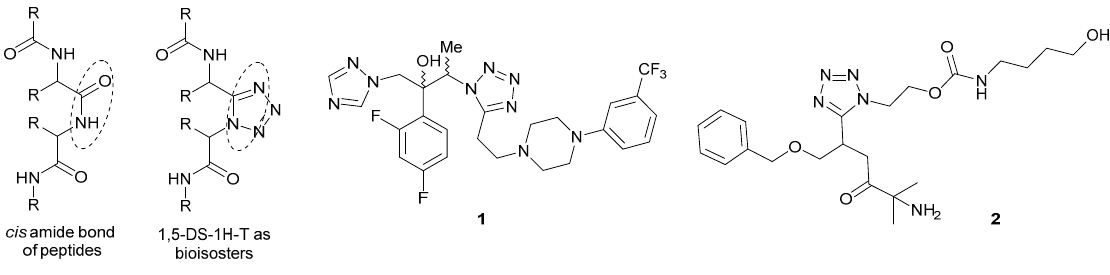
Figure 1. Some representative 1,5-disubstituted-1 H -tetrazoles (1,5-DS-1 H -T) having biological